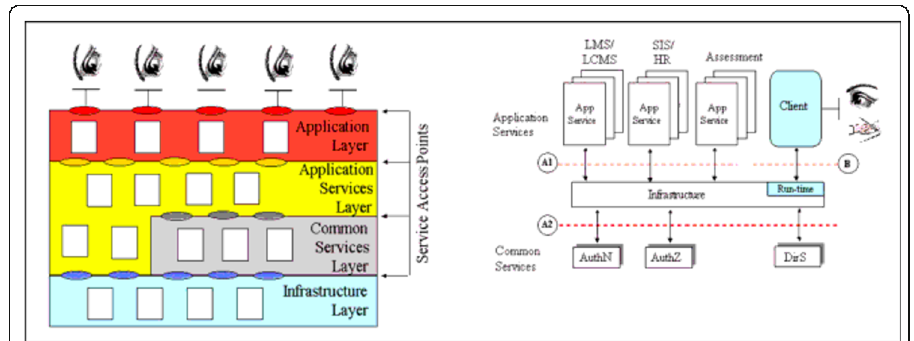
Fig. 10 IMS abstract framework (IMS,